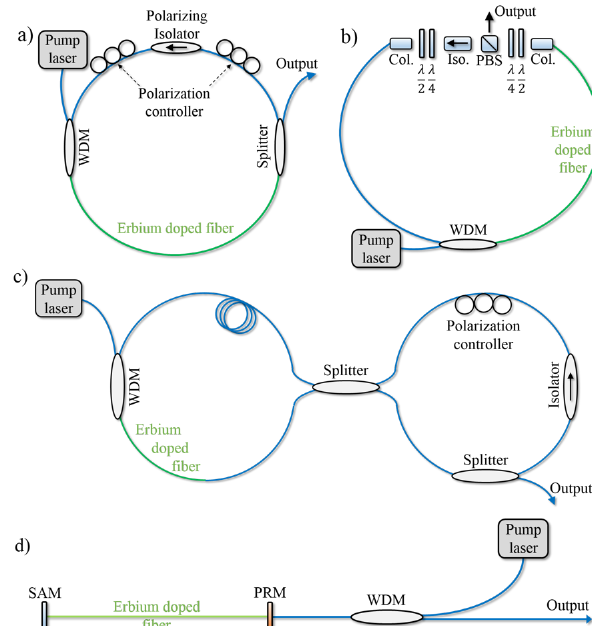
Figure 3: Some of the most widely used mode-locked erbium fiber oscillator designs. a) Simple ring laser based on nonlinear polar- ization evolution (NPE). The polarization controllers are adjusted in such a way that light with high intensity passes the polarizer while light with weaker intensity is blocked, therefore, favoring mode-locking operation. b) Modified NPE laser design that uses free-space optics for enhanced precision in polarization control. c) Figure-of-eight erbium fiber laser. The left side constitutes a nonlin- ear amplifying loop mirror (NALM). See text for details. d) Saturable absorber mirror (SAM) based mode-locked fiber laser. The